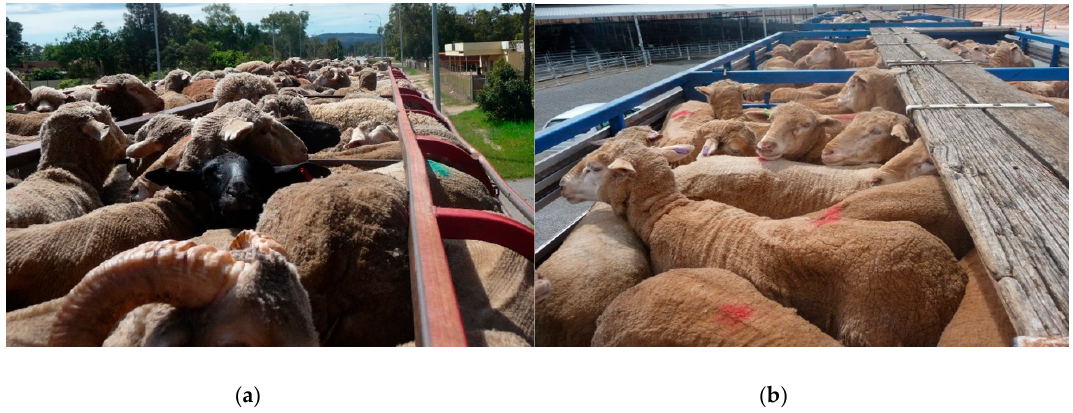
Figure 3. Views of merino sheep on the top deck in a ( a ) standard crate and ( b ) convertible crate. Note the curved side rail in ( a ) and straight side rail in ( b ).